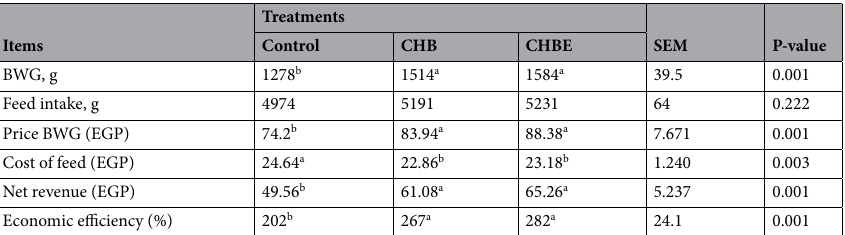
Table 7. Effects of hydroponic barley with or without enzymes on economic return of growing rabbits. SEM: Standard error of the means (n = 20); CHB: Control diet substituted with 25% hydroponic barley; CHBE: Control diet substituted with 25% hydroponic barley with 0.5 g/kg enzymes; BWG: Body weight gain; EGP: Egyptian pounds. 1 USD = 15 EGP. Economic efficiency ( % ) = Net revenue Total feed cost × 100 . Net revenue = Price of weight gain − total feed cost. a,b Means within the same row bearing different superscripts differ significantly (P <